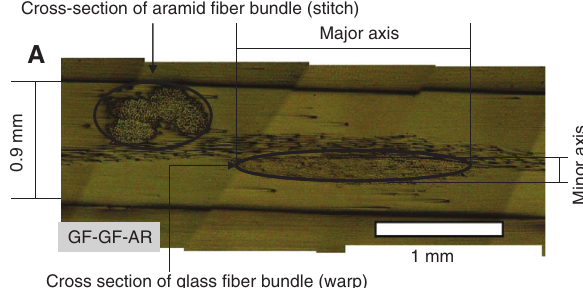
Table 6 Material constants of FEM of tensile modulus.